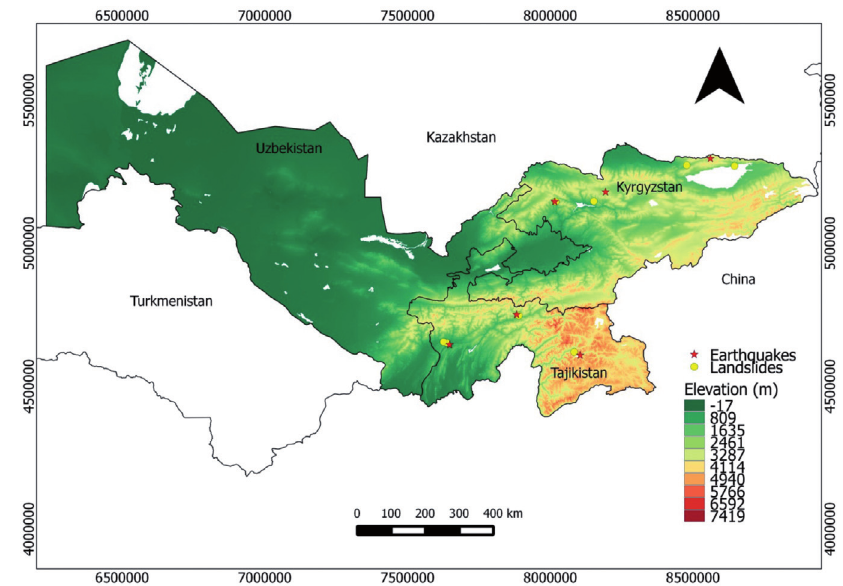
Figure 1. Location map of the study area and some among the strongest past earthquakes and seismically-induced landslides. In particular, the 1911 Sarez (Tajikistan), the 1911 Kemin (Kyrgyzstan), the 1946 Chatkal (Kyrgyzstan), the 1949 Khait (Tajikistan), the Gissar (Tajikistan), and the 1992 Suusamyr (Kyrgyzstan) earthquakes are known to have triggered the 1911 Usoi (Tajikistan), the 1911 Ananievo and Kaindy (Kyr- gyzstan), the 1946 Chatkal (Kyrzgystan), the 1949 Khait (Tajikistan), the 1989 Sharora and Okuli-bolo (Tajikistan), the 1992 Belaldy (Kyr- gyzstan) landslides,